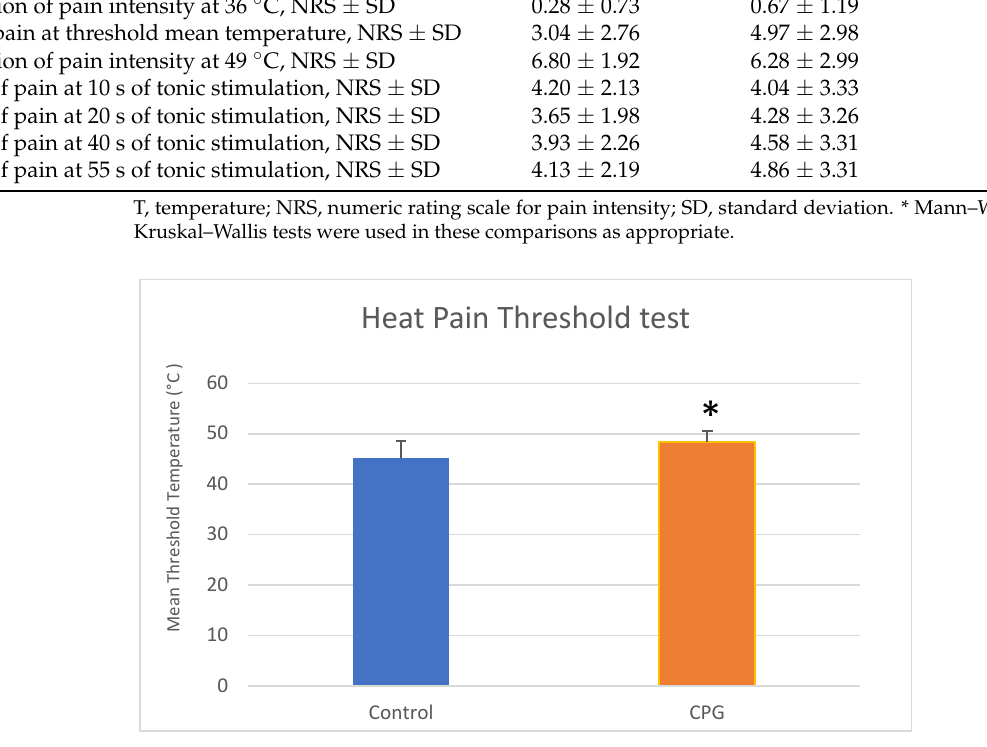
Figure 3. Comparison of mean ± SD heat pain threshold temperatures (°C) between the control group and the CPG using Mann–Whitney U test (* p < 0.05). SD, standard deviation; CPG, chronic